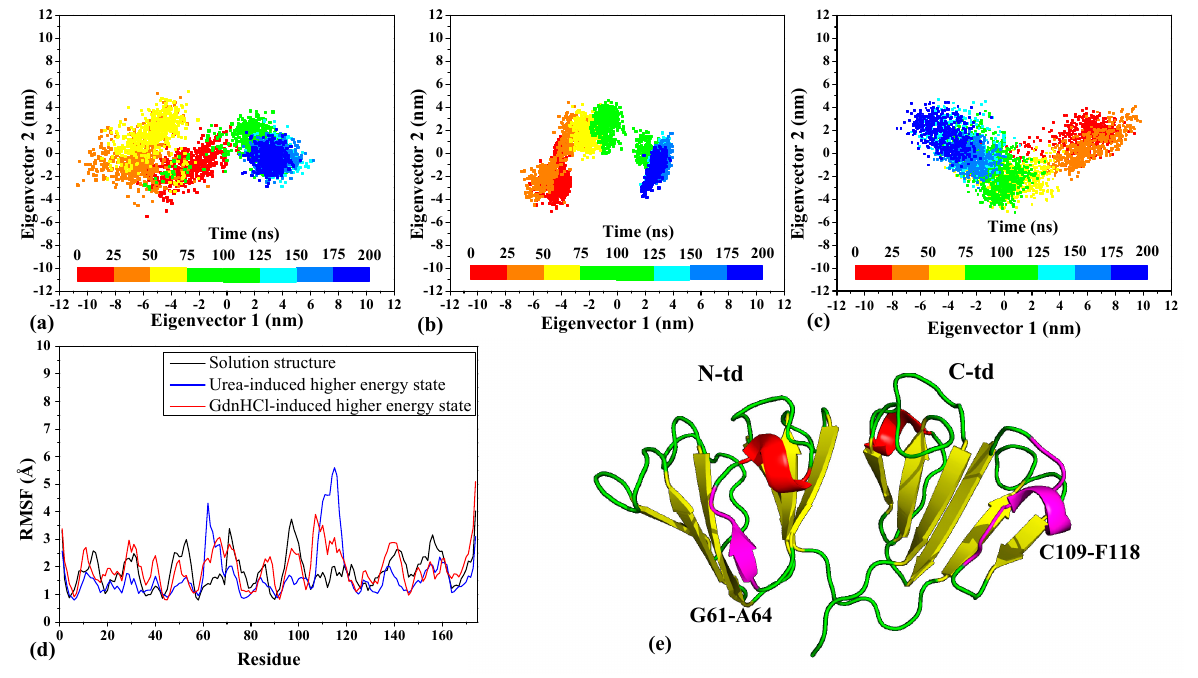
Figure 2. The 2D scatter plots, root–mean–square (RMSF) per residue for the simulated trajectories of HGDC structures in physiological solution (343 K) for 200 ns, and the secondary structural schematic of HGDC. The scatter plots are projected to the top two principal components for the simulated trajectories of ( a ) solution, ( b ) urea-induced, and ( c ) GdnHCl-induced structures. ( d ) Backbone RMSF values for all three HGDC structures. ( e ) Residues G61–A64 and C109–F118 represented in magenta highlights in the HGDC structure.